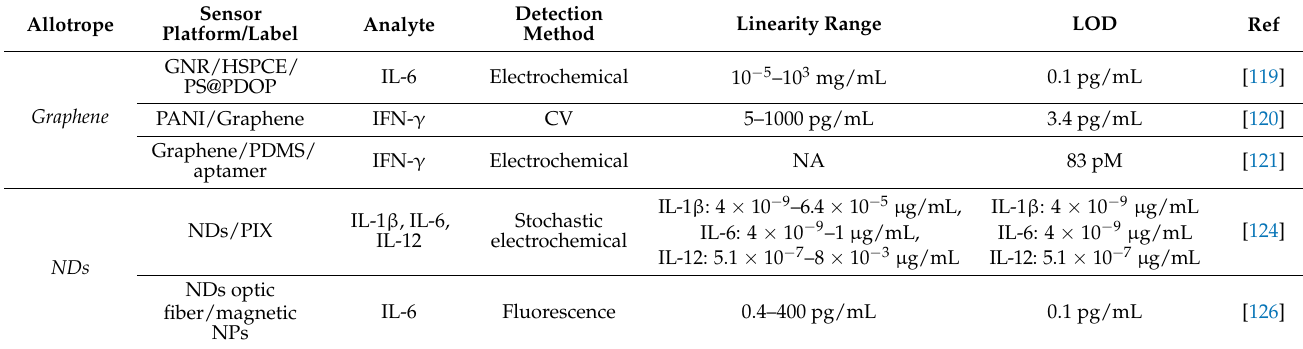
Table 3. Recent studies on carbon nanomaterials-based cytokine biosensors mentioned in this review. Sensor Allotrope